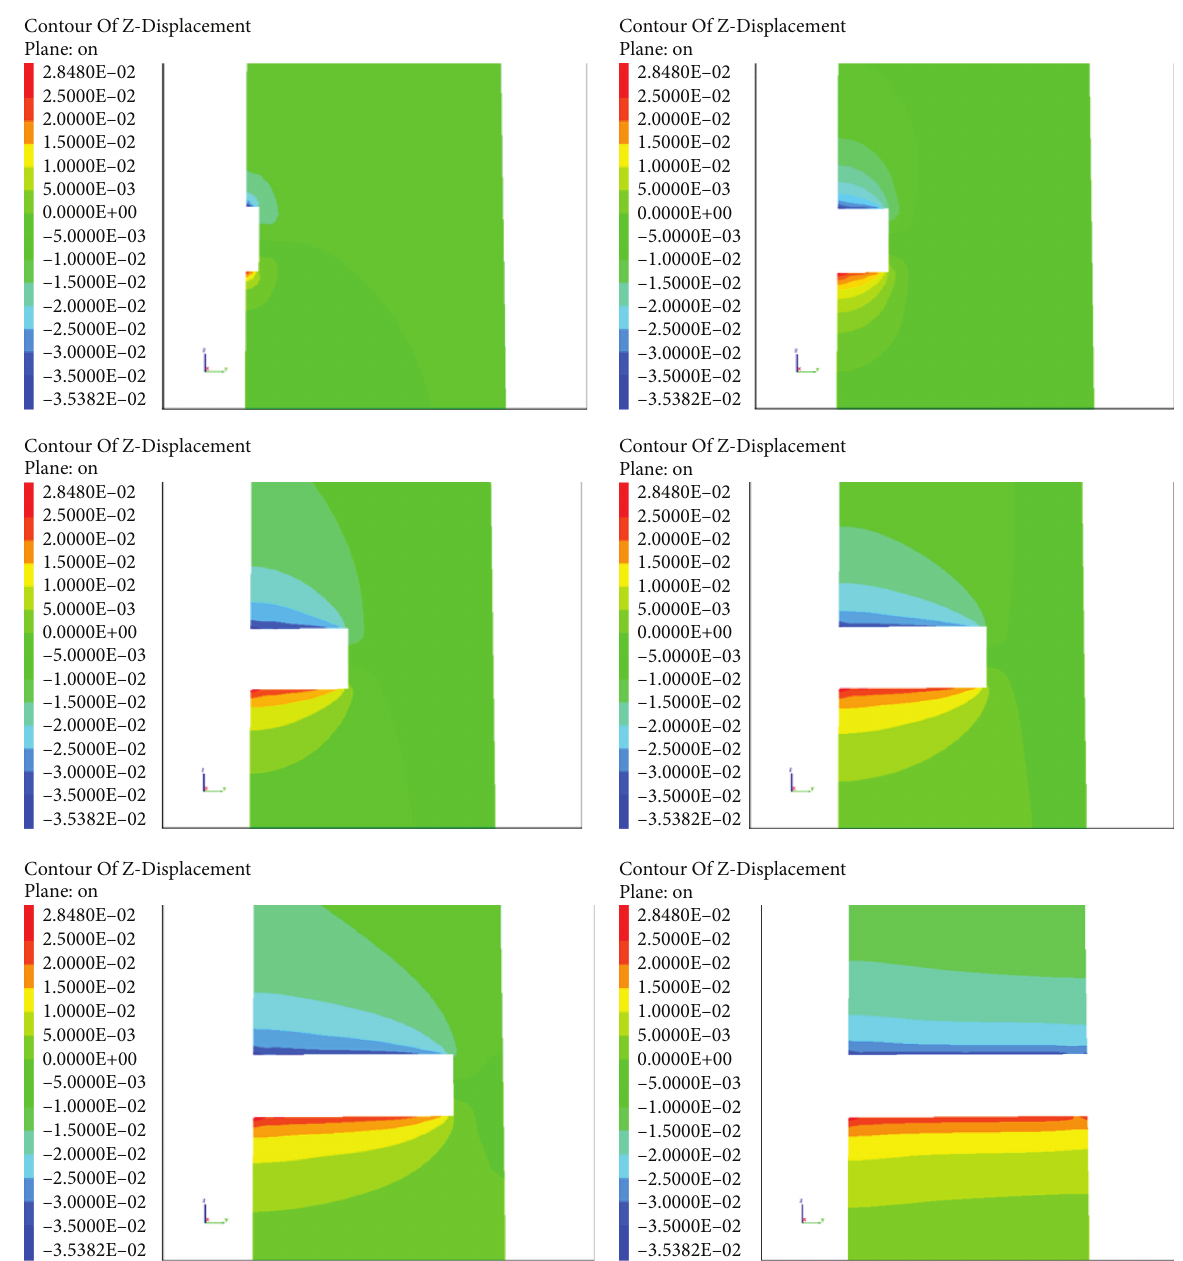
Figure 10: Development of vertical displacement of rock mass in the middle of tunnel